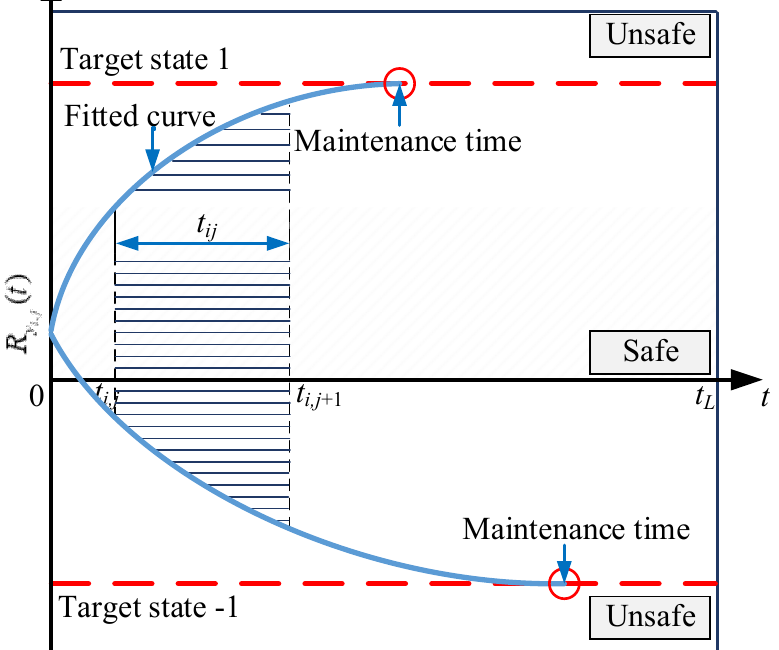
Figure 5. Determination diagram of the unfavorable maintenance